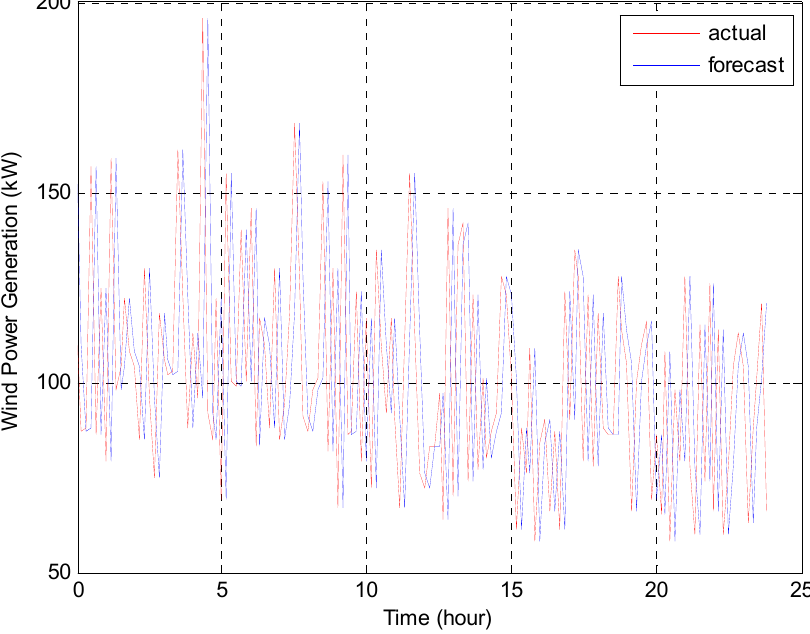
Figure 10. Test results with the persistence method for typical summer day.